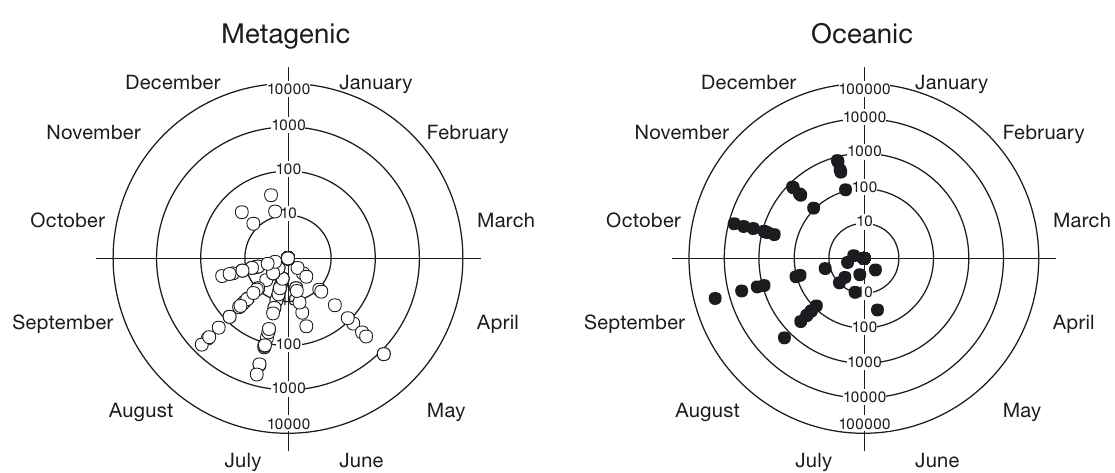
Fig. 4. Circular−linear plots showing the number of coastal (left) and oceanic (right) jellyfish stranded on all beaches through- out the year. The circular axis represents month, and position on the grid indicates number of jellyfish observed. Points on the plot represent the number of stranded jellyfish recorded from 1 beach survey. These plots indicate how coastal jellyfish species consistently strand between May and September, whilst the oceanic species strand from August to December. Note the use of log 10 scales and differences in axis